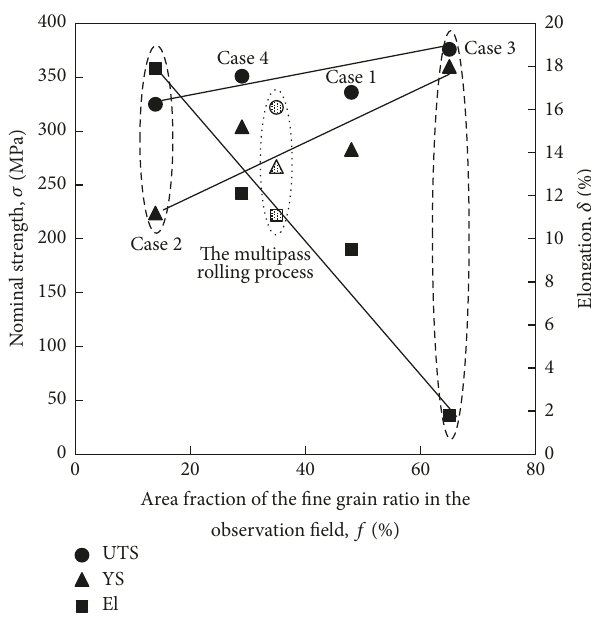
Figure 6: Relationship between the area fraction of the fine grain ratio in the observation field and the mechanical properties under rolling conditions of case 1 to case 4 and the results of the multipass rolling process (Section 3.2). The circle, triangle, and square symbols represent UTS, YS, and El,